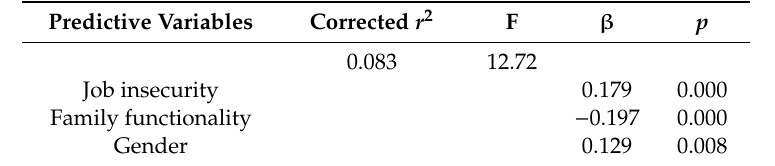
Table 2. Variables that predict global